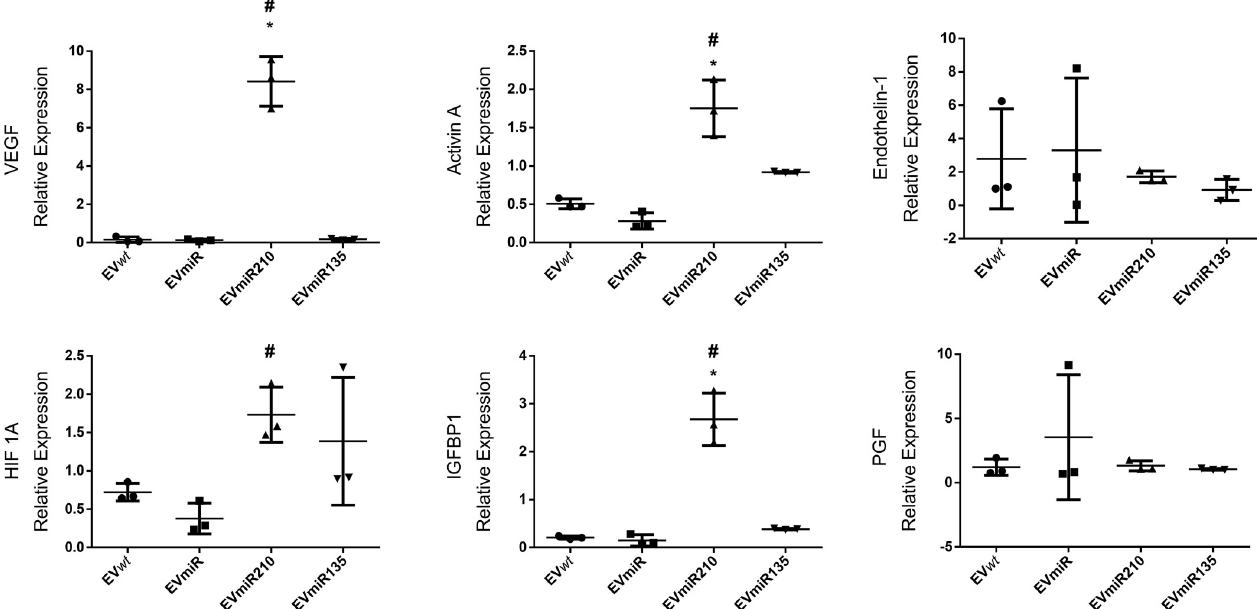
Fig 7. Angiogenic gene expression profile of HUVECs after treatment with EVmiRs. Relative gene expression was determined as described in the Materials and Methods section. The significance of the differences was analyzed by one-way ANOVA and Bonferroni correction for the post hoc analysis. � indicates p < 0.05 in comparison with EV wt s; # indicates p < 0.05 in comparison with EVmiRs. EV wt s = MSCwt-derived EVs; EVmiRs = MSCmiR-derived EVs; EVmiR210s = MSCmiR210-derived EVs; EVmiR135b = MSCmiR135b-derived EVs.